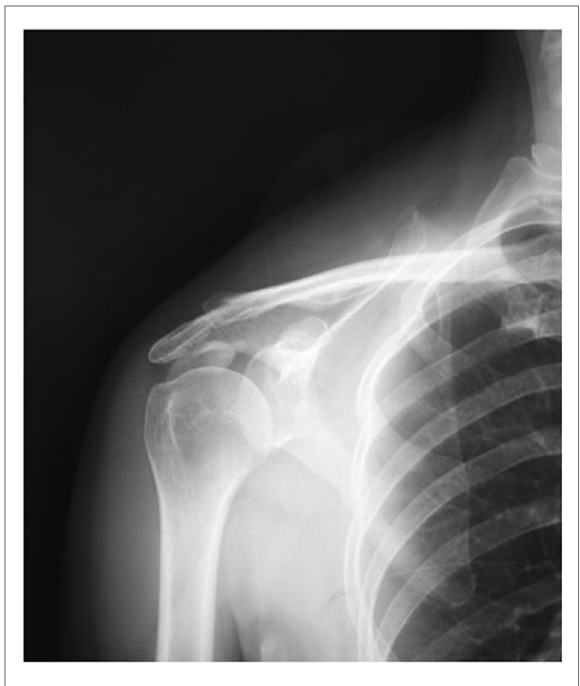
FIGURE 1 X-ray (front) showed clear calci fi c deposits in the target